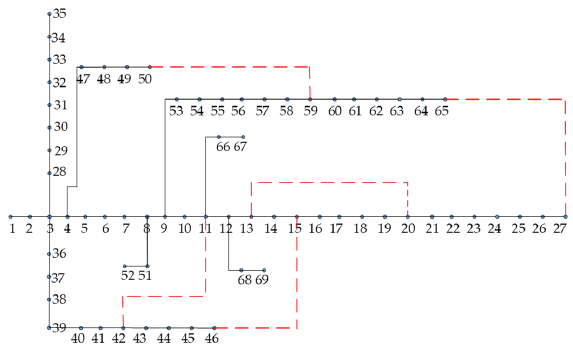
Figure A2. IEEE 69-bus system.